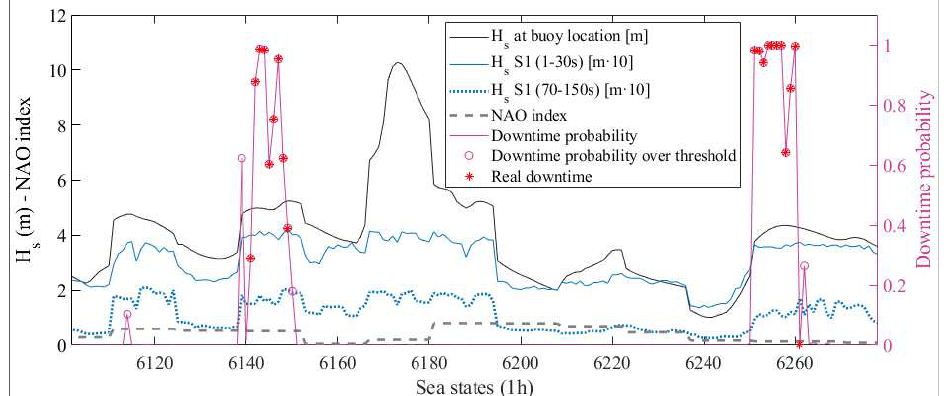
Figure 10. Time series of significant wave heights, NAO index, and downtime probability with real events.